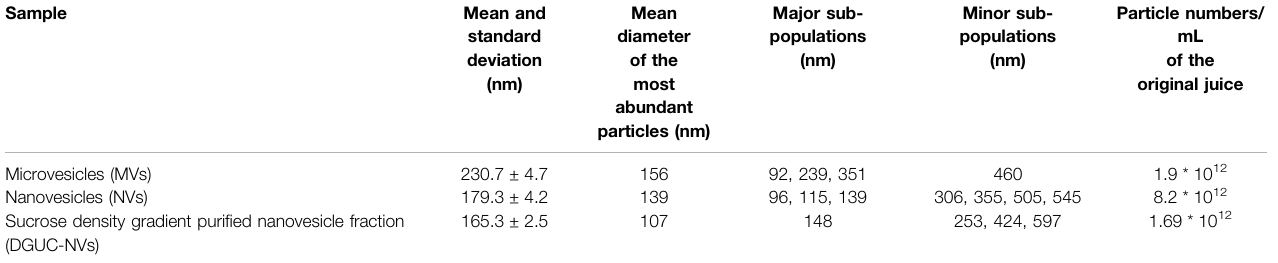
TABLE 1 | The particle concentration and the size range of different vesicle populations isolated from strawberries.